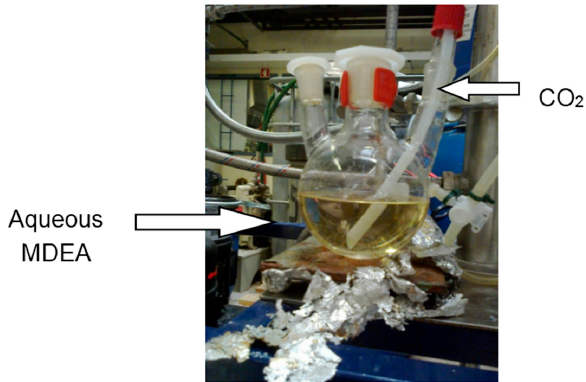
Figure 2. Illustration of experimental tests carried out to study the absorption of CO 2 from aqueous amines solutions